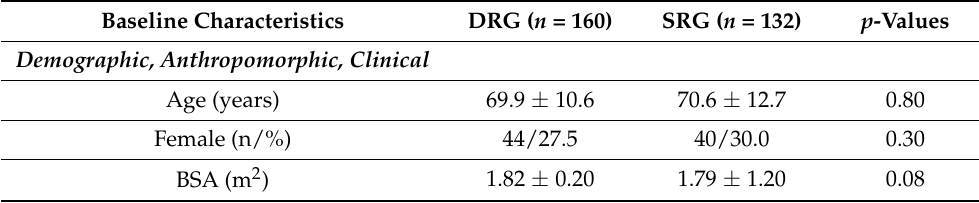
Table 1. Baseline characteristics of the study population stratified for DRG and